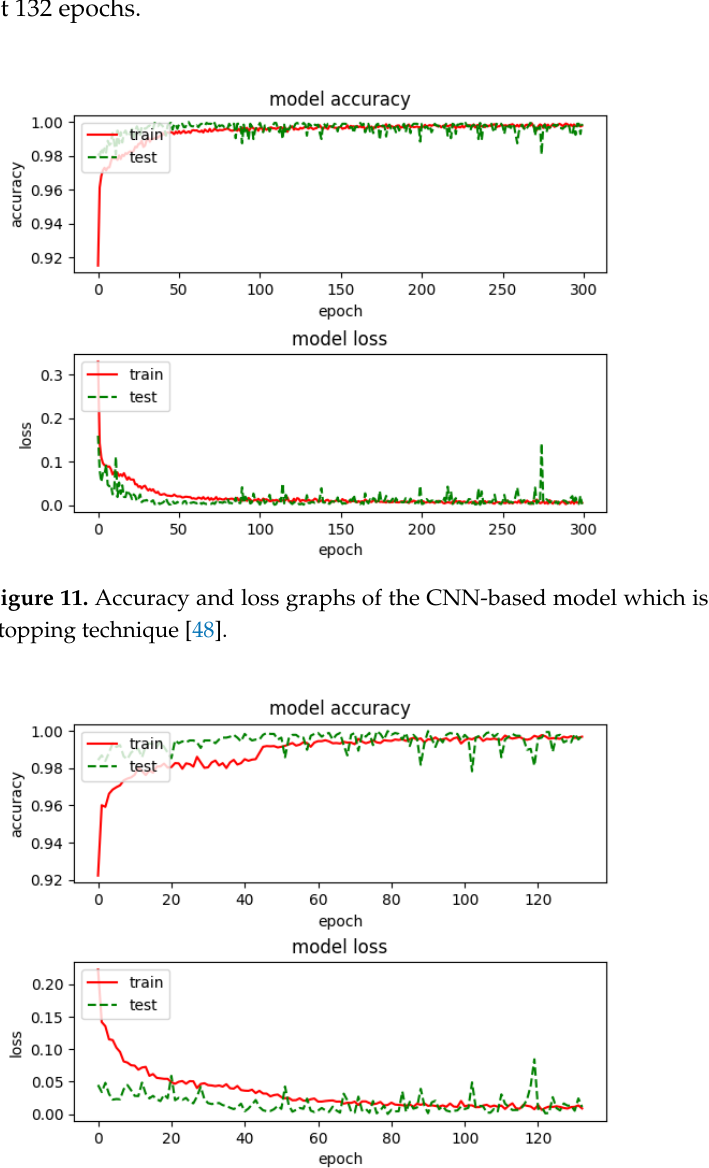
Figure 12. Accuracy and loss graphs of the CNN-based model with the early stopping technique